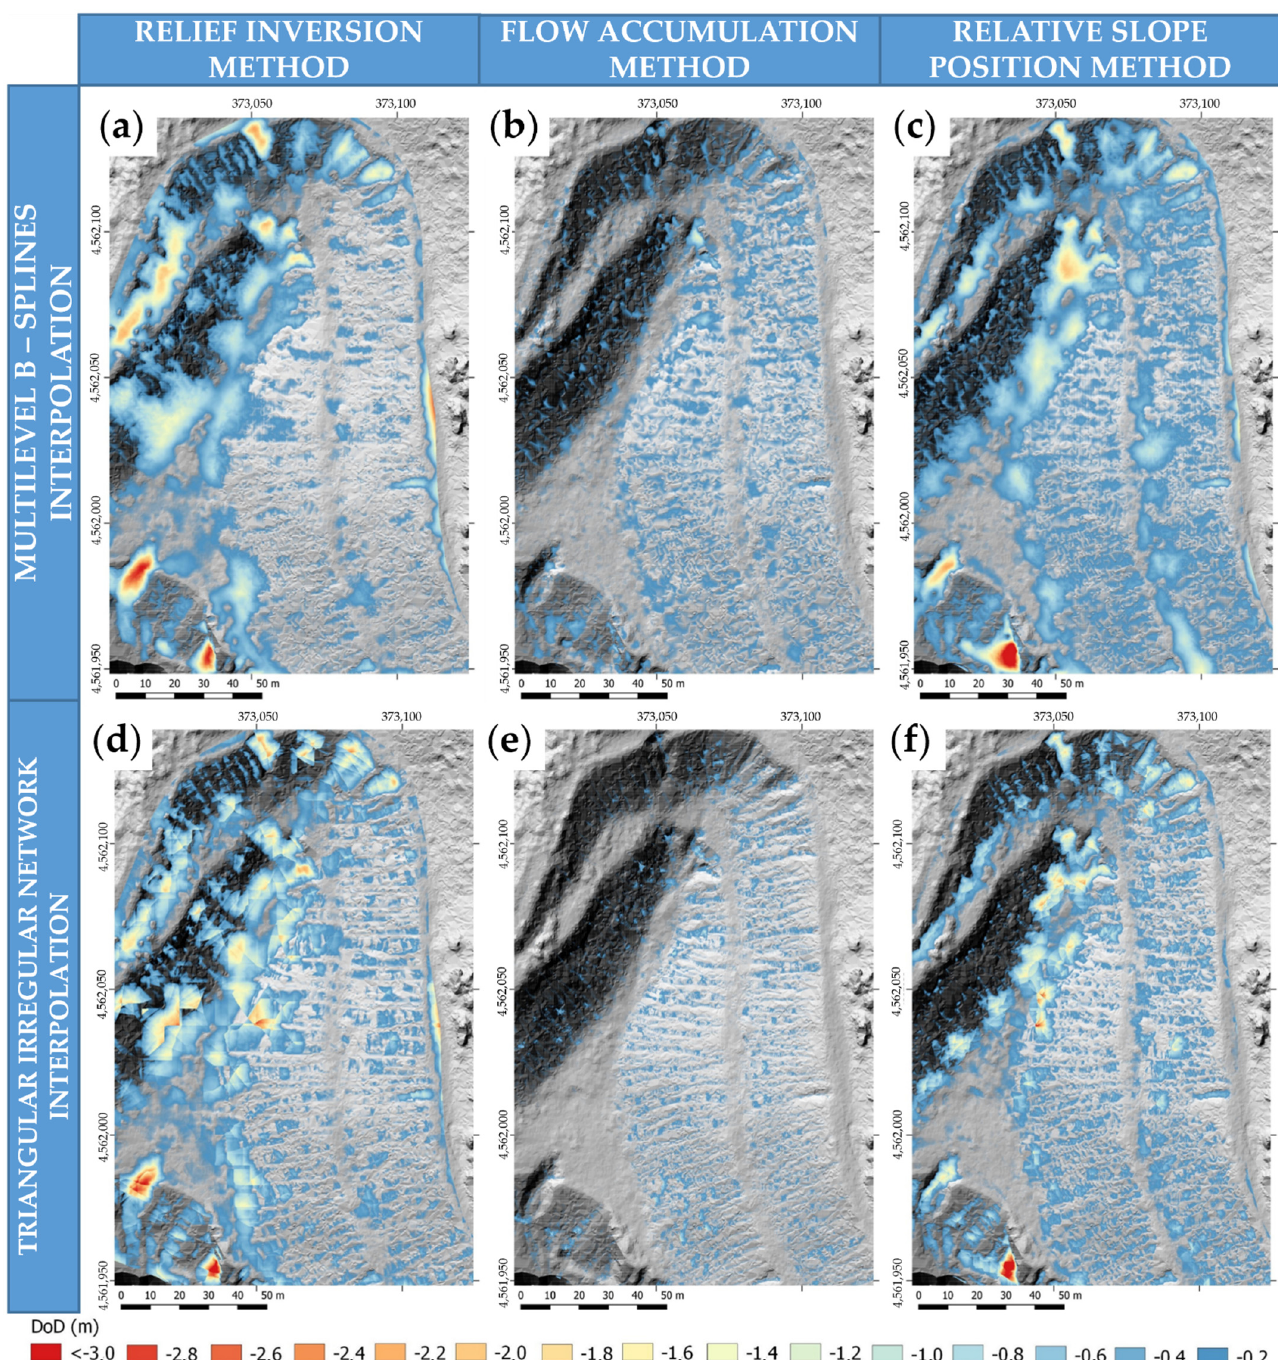
Figure 5. DEM of Differences (DoD) using different combination of relief modelling and interpolation methods: ( a ) through relief inversion and Splines interpolation; ( b ) flow accumulation and Splines interpolation; ( c ) relative slope position and Splines interpolation; ( d ) relief inversion and TIN interpolation; ( e ) flow accumulation and TIN interpolation; ( f ) relative slope position and TIN interpolation. The colors represent the depth of the gully. Values below 0.2 to 0 are shown in transparent.